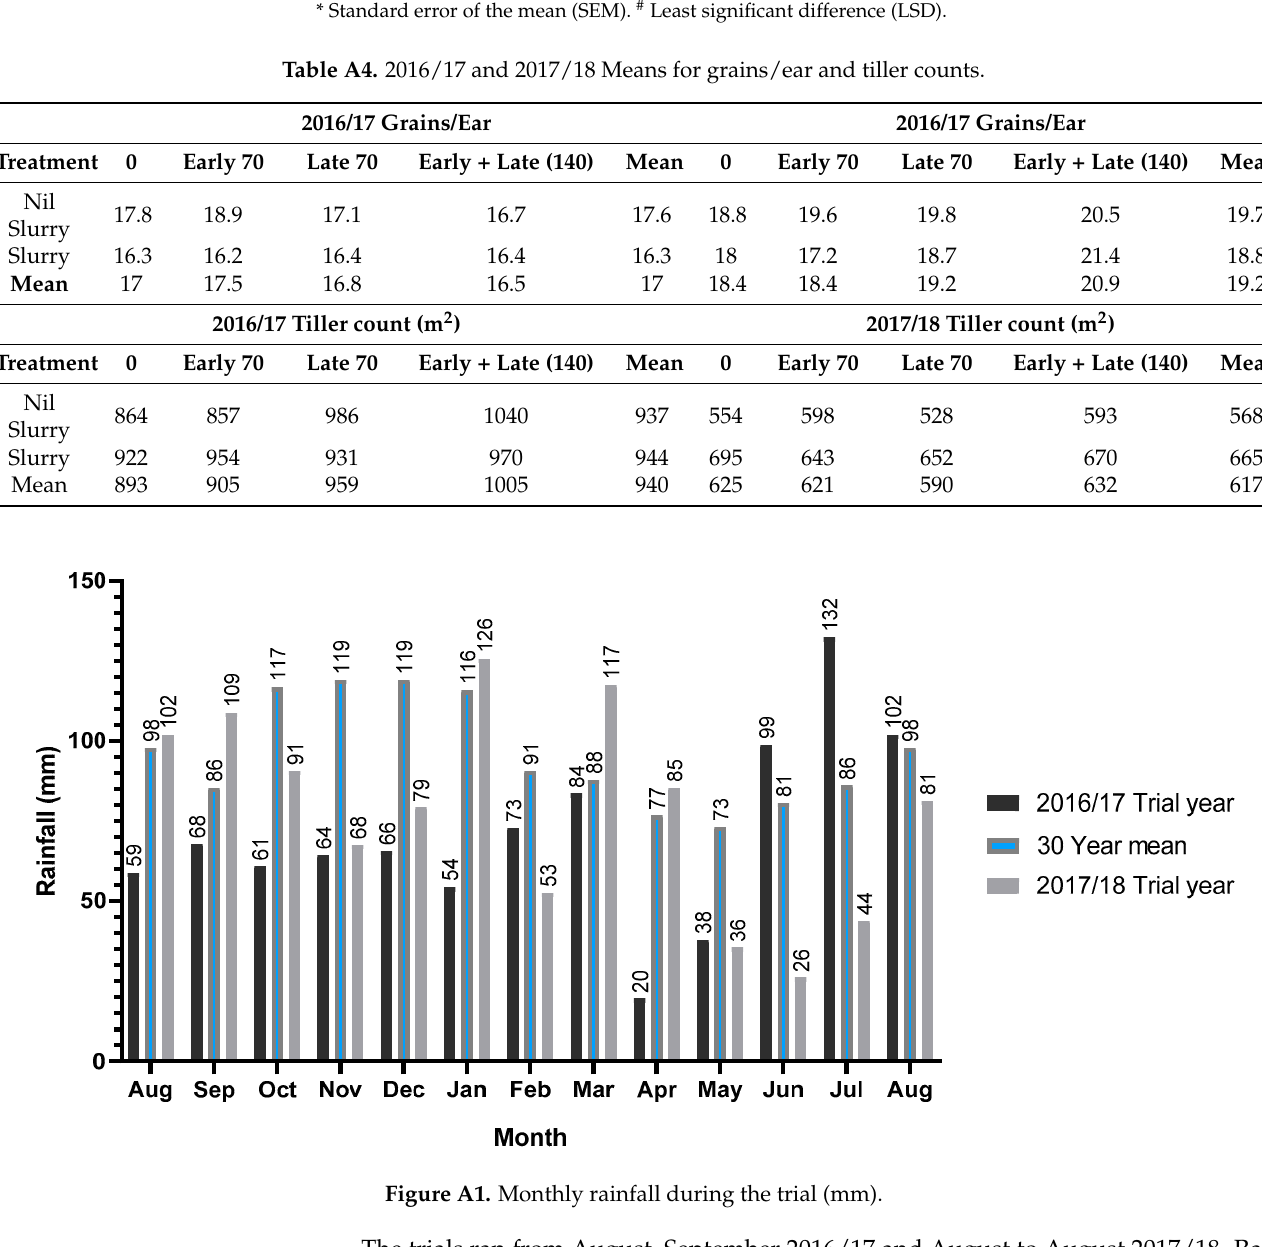
fall data gathered from a weather station located in Crossnacreevy, Belfast. The 30-year mean NI rainfall was obtained from the Met Office. cumulative rainfall total = 1016